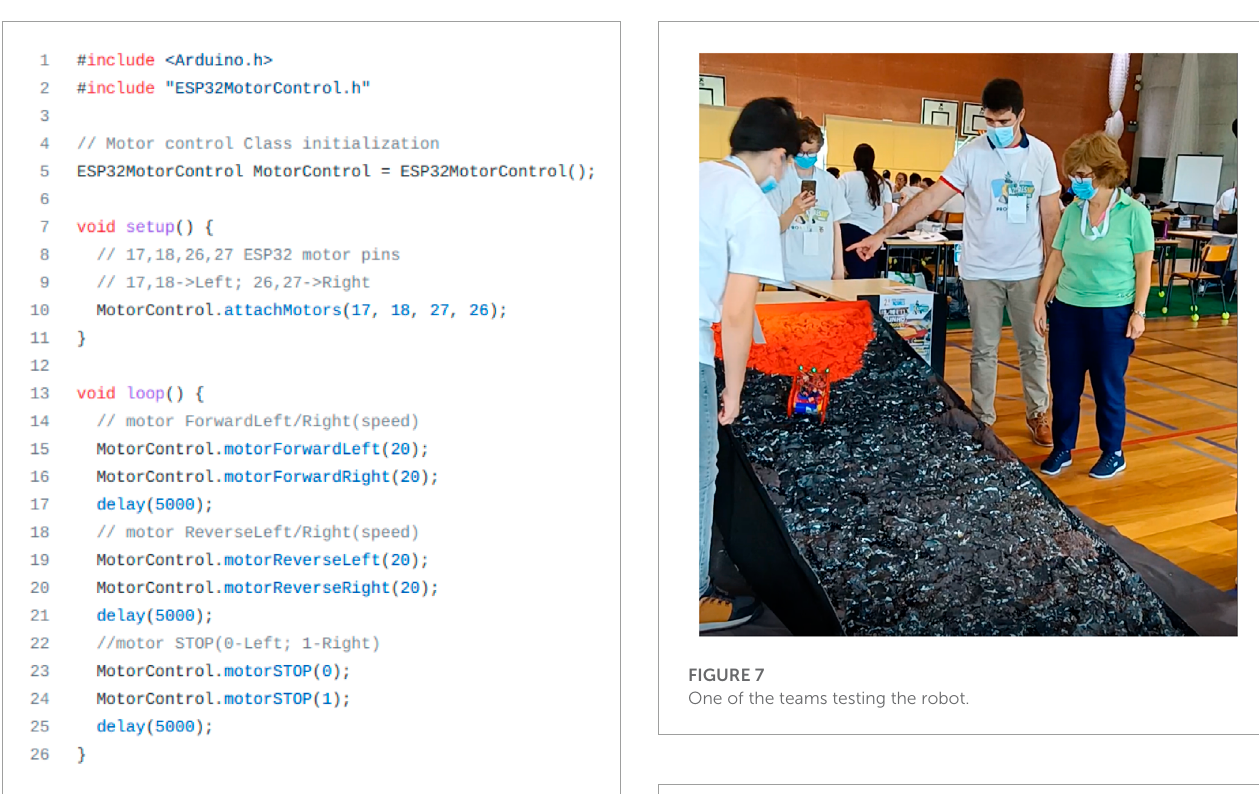
FIGURE 6 Sample code to test motors.